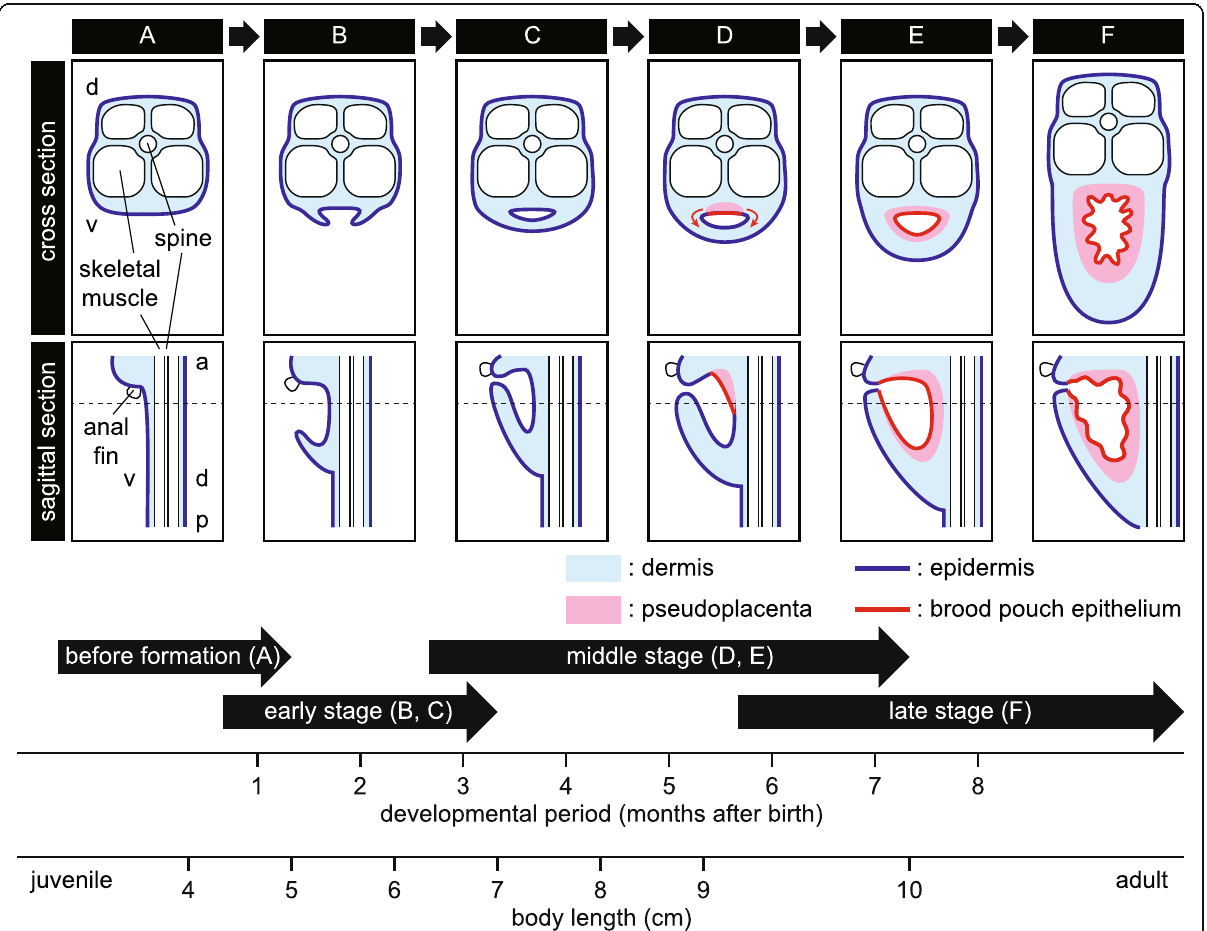
Fig. 10 A proposed pathway of brood pouch formation in the seahorse. The pathway is schematically shown in both cross-sectional and sagittal views. a Before formation of the brood pouch. b The primordium of the brood pouch first appears as linear projections at both ventrolateral sides of the body. c The projections become fused at the body midline. d Differentiation of brood pouch tissue begins, and the pseudoplacenta first appears on the dorsal side of the pouch. e The pseudoplacenta eventually surrounds the pouch entirely. f Finally, the pouch-folds are formed, ready to incubate embryos. Dotted lines in sagittal views indicate locations of cross-sectional views. The typical developmental periods of the brood pouch stages and body length are given at the bottom of the figure. Formation may differ between individuals depending on rearing temperature and/or nutrition. a, anterior; d, dorsal; p, posterior; v,